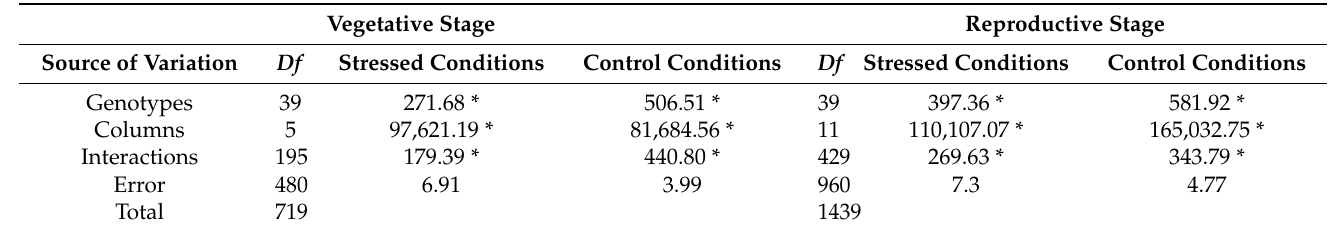
Table 2. ANOVA for different morpho-physiological traits studied in chickpea genotypes at vegetative and reproductive